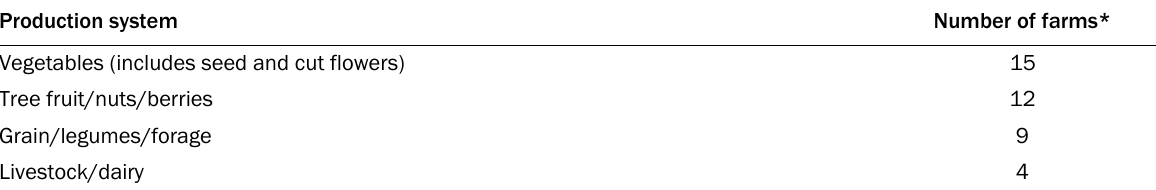
Table 1. Farm Production Systems Production